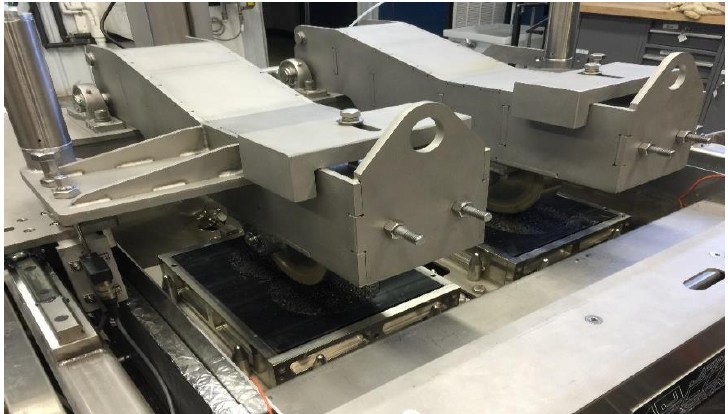
Figure 1. Hamburg wheel-tracking device.